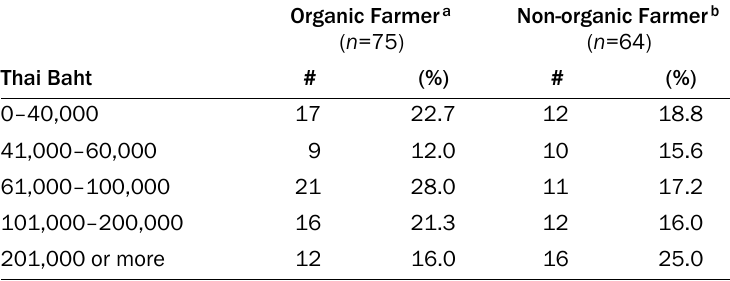
Table 5. Differences in the Range of Income from Agriculture Between Organic and Non-Organic Farmers